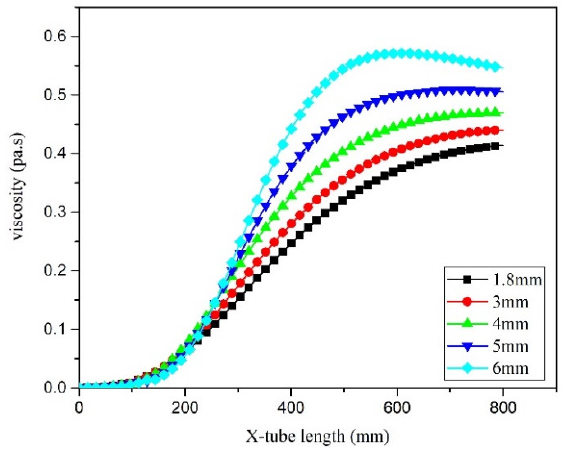
Figure 20. Viscosity curve in microreactor at different pipe diameters.